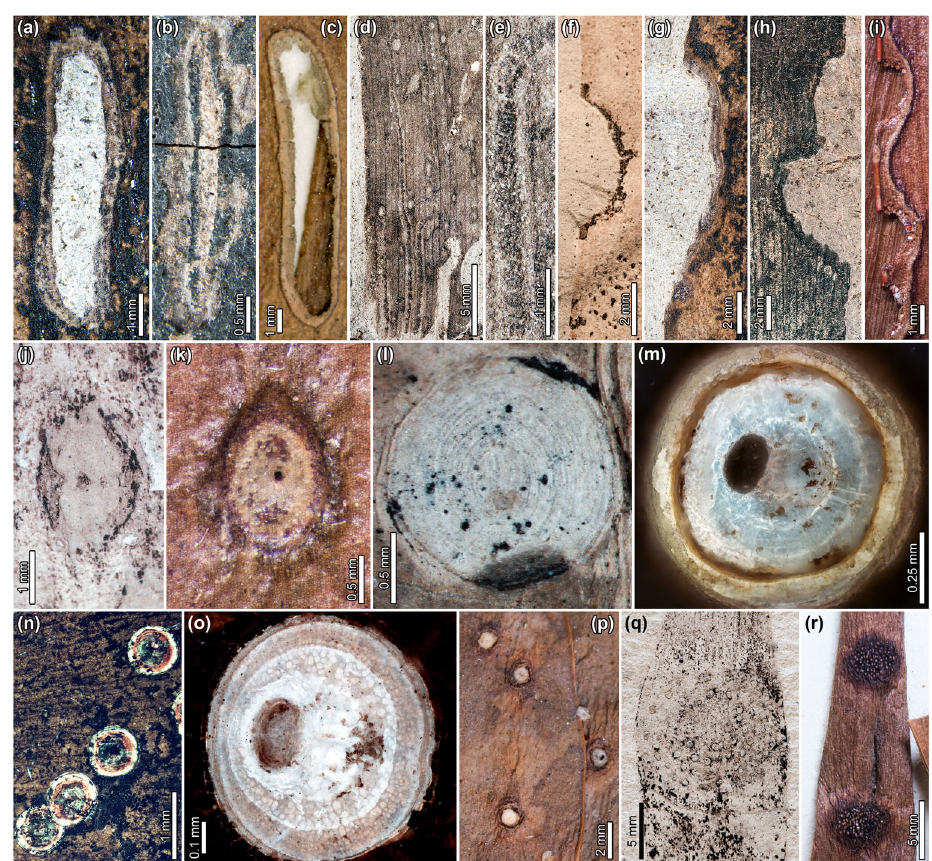
Fig. 2 External foliage feeding, blotch and serpentine mining, galling, and possible armored scale insect remains (Diaspididae) on fossil and extant Agathis . a Putative blotch mine, or slot feeding, characterized by parallel sides and fl aps of necrotic tissue on A. zamunerae (early Eocene, LH13, MPEF-Pb 6361). b Elongate blotch mine with breached epidermal tissue and thickened reaction rim on A. zamunerae (early middle Eocene, RP, USNM